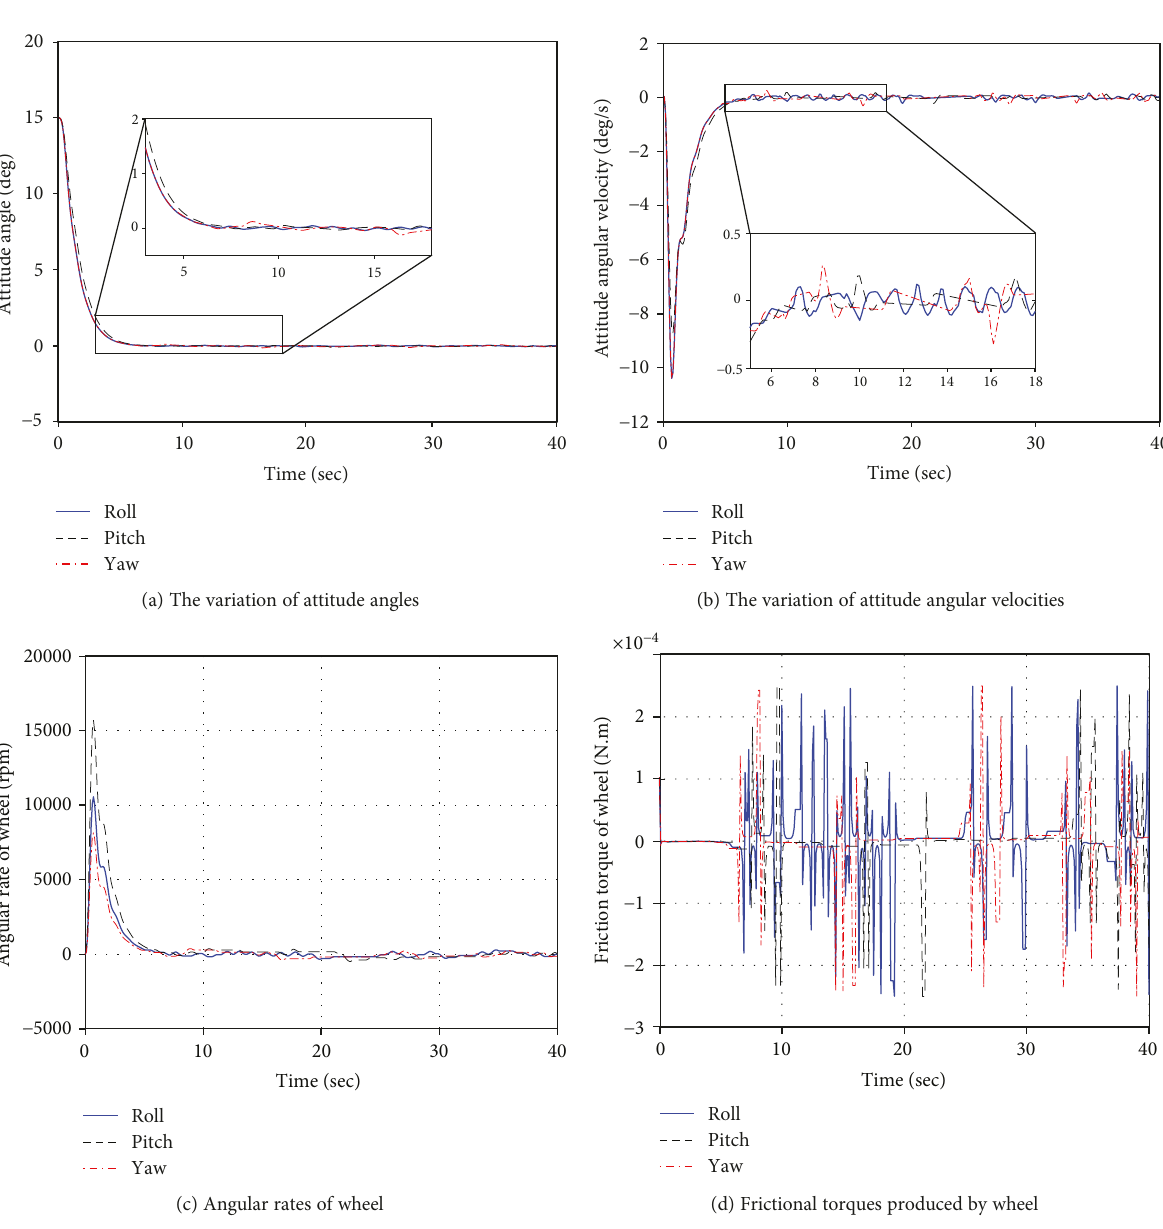
Figure 18: Control results of